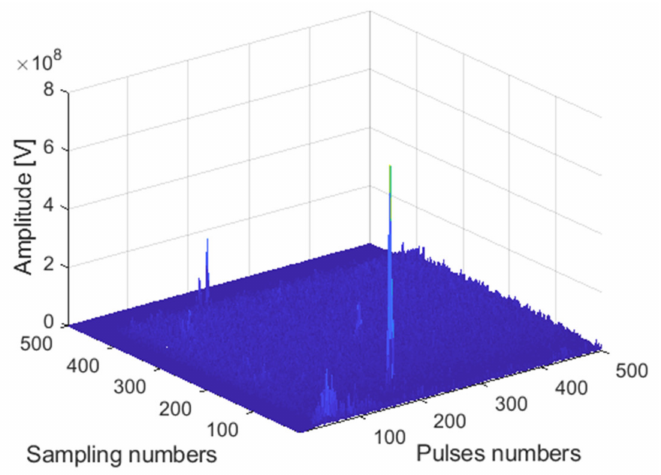
Figure 17. GPU DBF result graph.